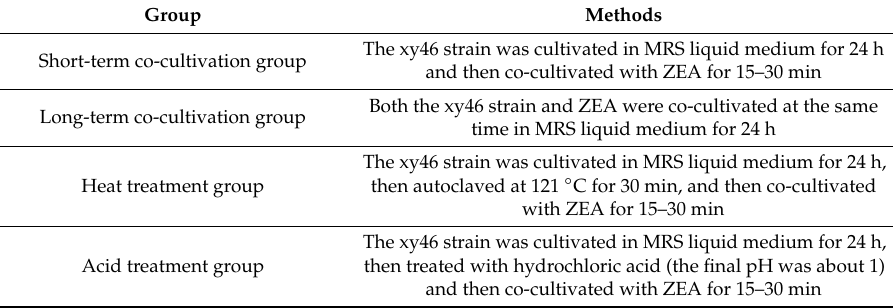
Table 1. The experimental design of the xy46 strain treated in di ff erent ways then co-cultivated with zearalenone